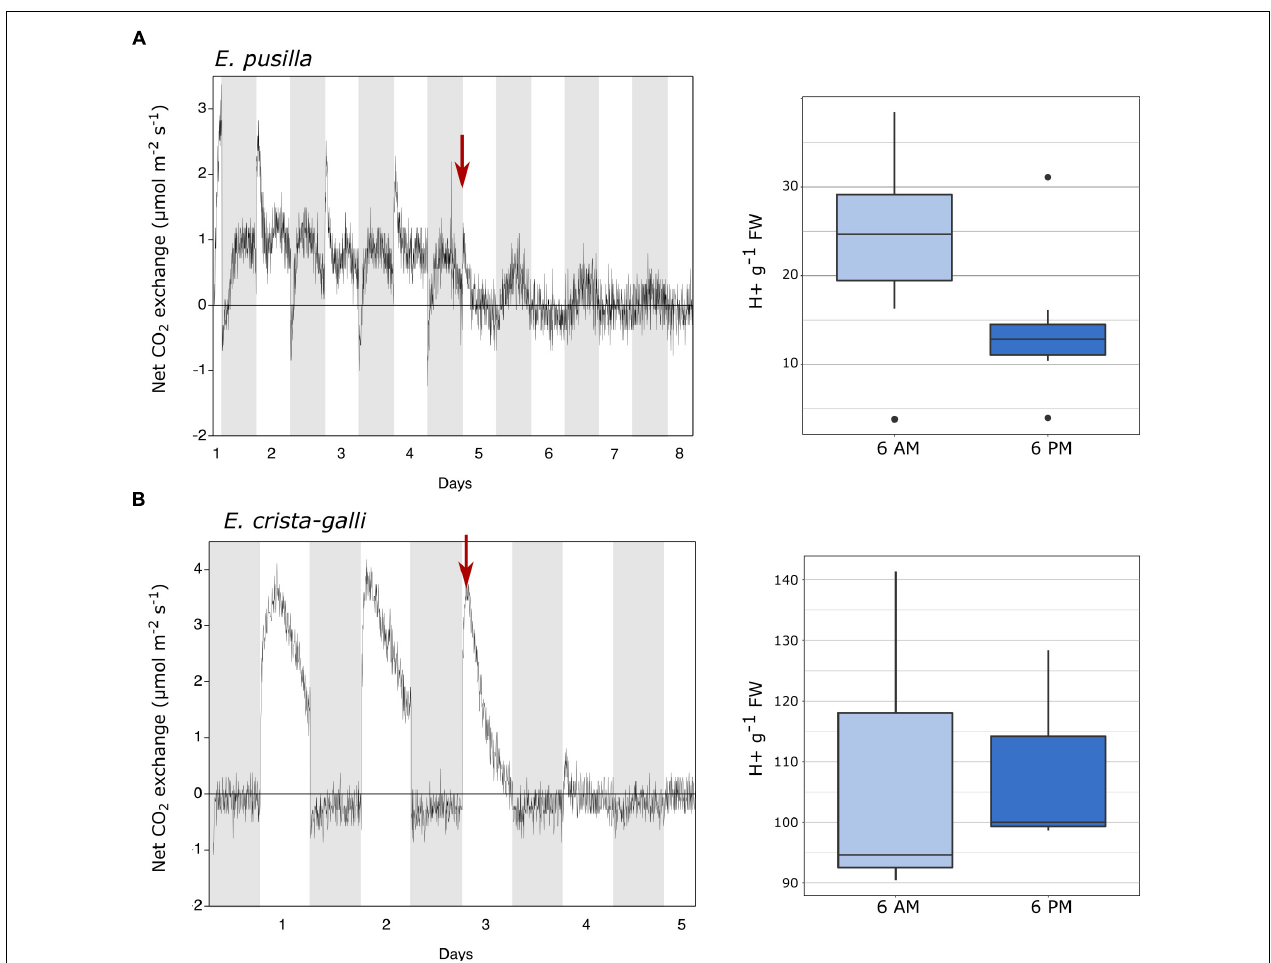
FIGURE 2 | Gas exchange and titratable acidity for (A) Erycina pusilla and (B) Erycina crista-galli. Gas exchange is shown for a single plant; replicate plant gas exchange plots can be found in Supplementary Figure 1 . Drought induction is indicated with a red arrow. Titrations are shown for dawn and dusk; full titratable acidity values are in Supplementary Table 2